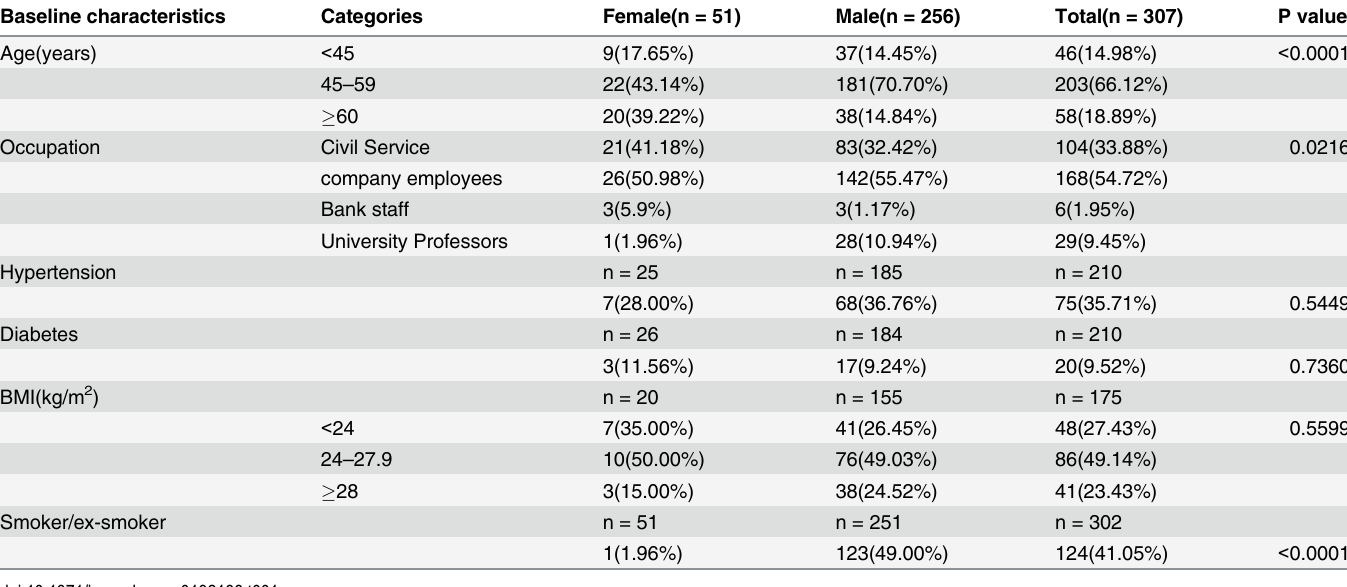
Table 1. Summarized on baseline characteristics of participants in this